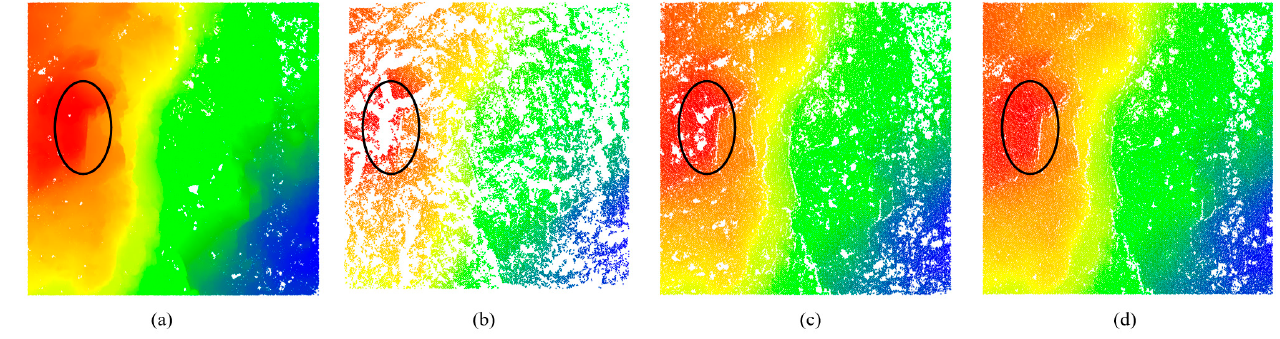
Figure 11. Validation results for the contribution in the ground seed identification step. ( a ) Benchmark ground points. The ground seeds identified through selecting the lowest points of the point clouds within ( b ) square and ( c ) multi-directional narrow windows. ( d ) The enhanced ground seeds after line segmentation. Ground seeds were identified more completely by multi-directional narrow windows, and the line segmentation could further improve the completeness of ground seeds on raised terrain. The content inside the ellipses indicates the differences in ground seeds on raised terrain.